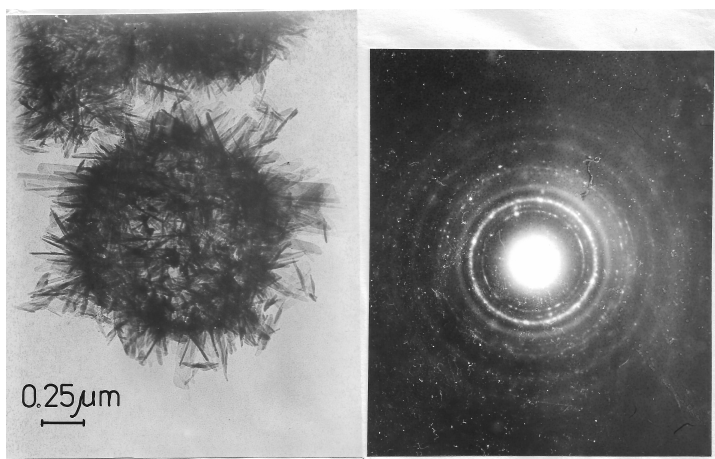
Figure 4. Transmission electron microscope image ( left ) and electron microdiffraction pattern ( right ) of aggrete from precipitated